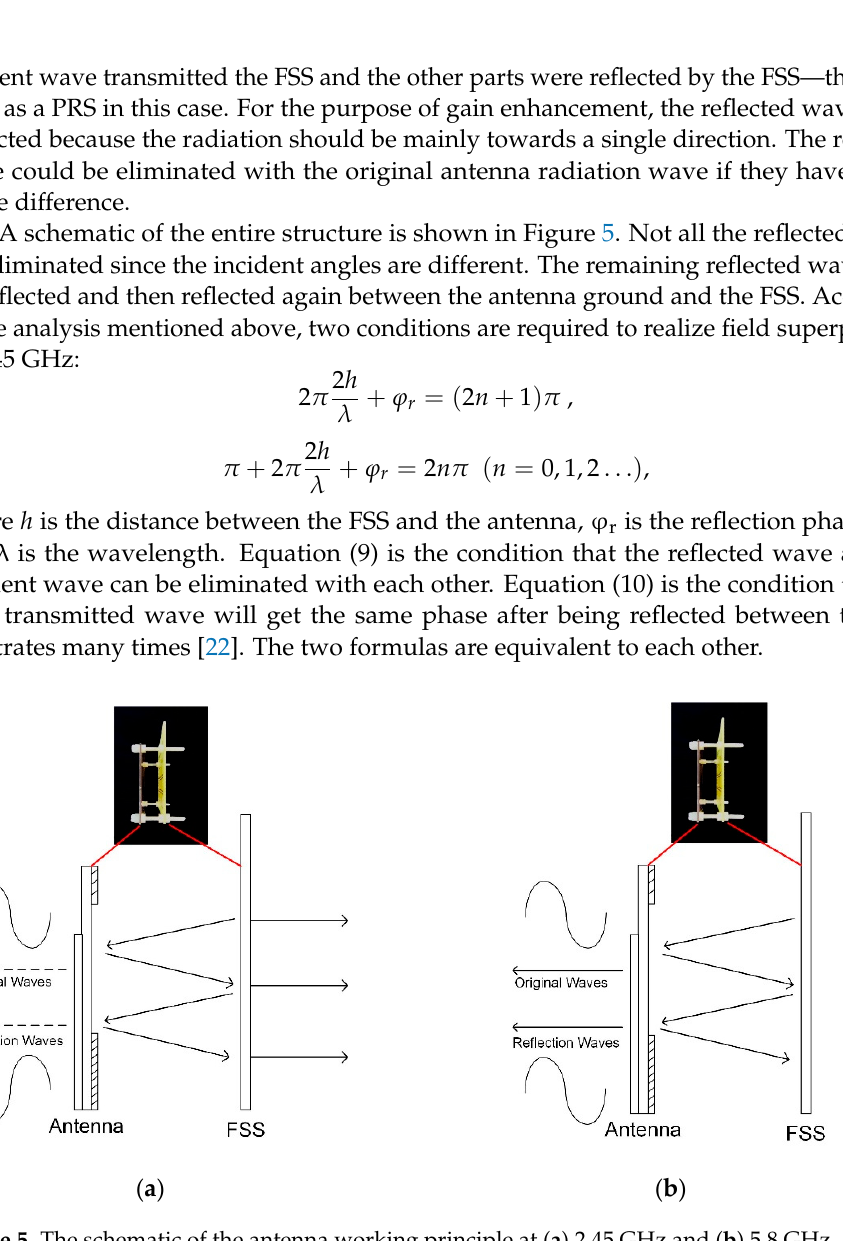
Figure 5. The schematic of the antenna working principle at ( a ) 2.45 GHz and ( b ) 5.8